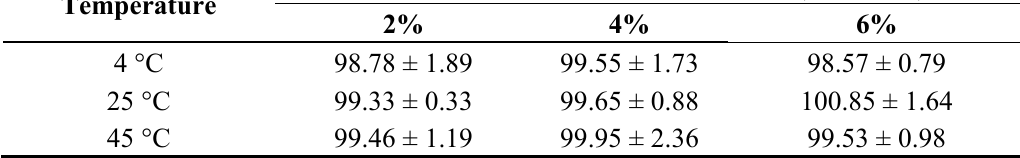
Table 3. EE and stability evaluation of MSKE in ZPG beads prepared with different COO) at 4, 25 and 45 °C after storage for four months. (Data represent percents of Zn(CH 3 2 the mean ± SD, n =